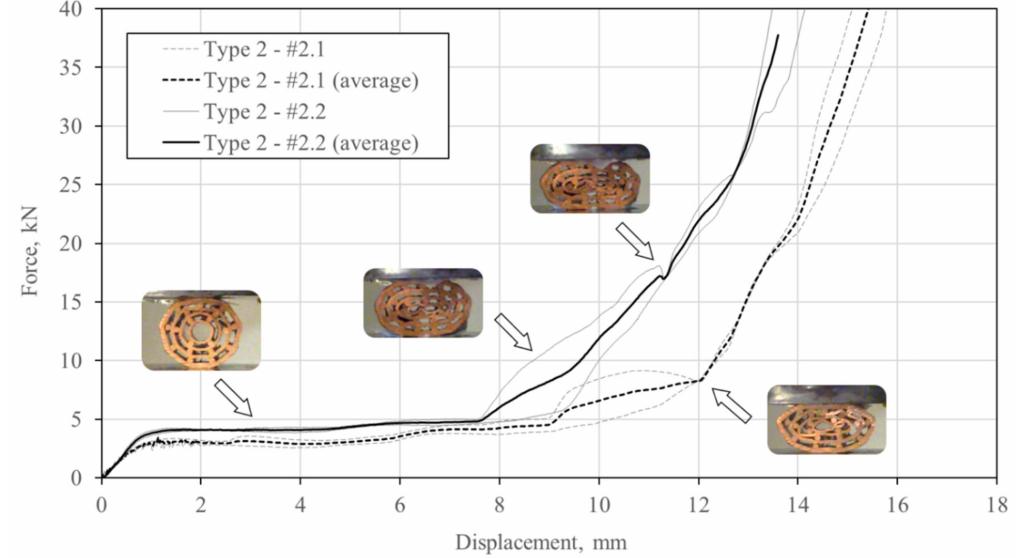
Figure 11. Compressive force–displacement relationship of the type 2